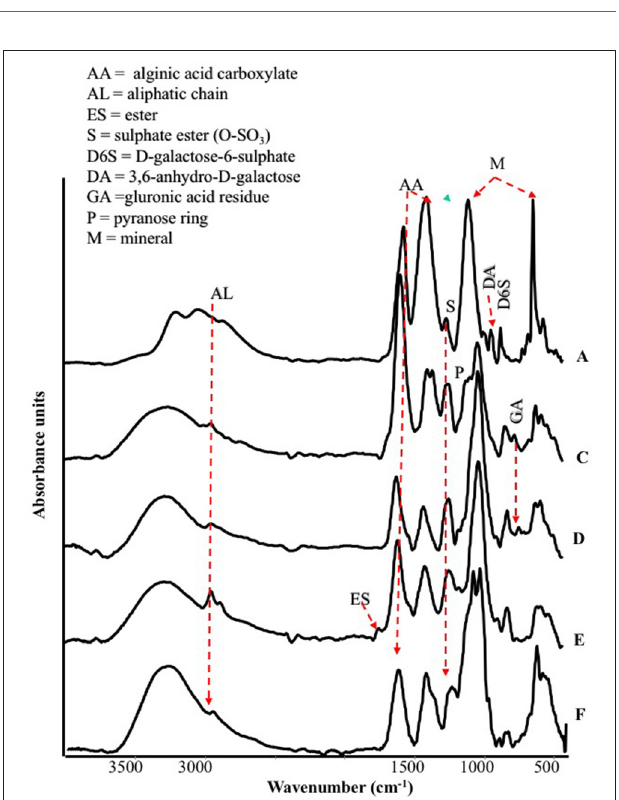
FIGURE 1 | ATR/FT-IR spectra of extracts derived from Laminaria (A) and from Ascophyllum nodosum spp. (C–F).